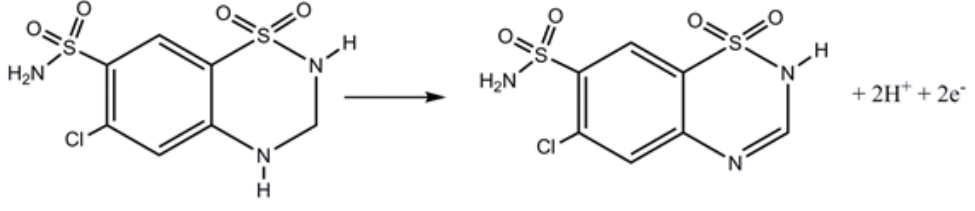
Scheme 1. Proposed mechanism for oxidation of